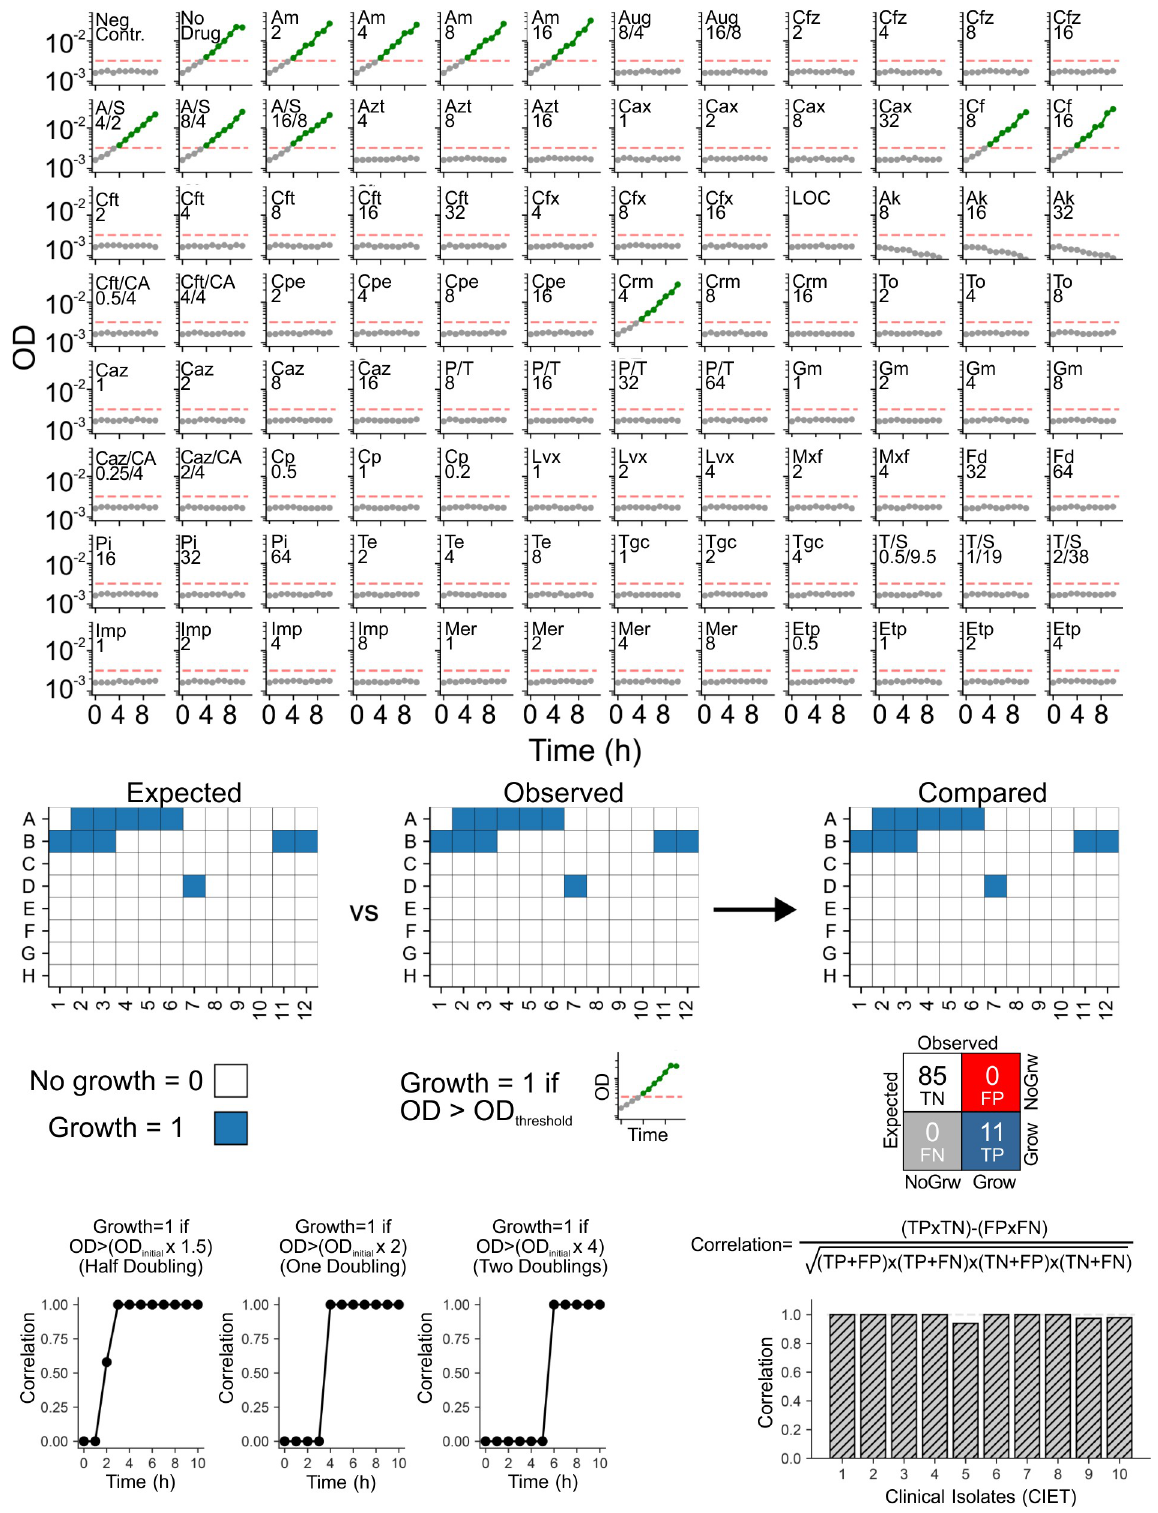
Fig 4. iFAST yields reliable results in shorter times in comparison to standard commercial clinical antibiotic susceptibility testing methods. (a) Utilizing the high sensitivity of the RUSD platform, iFAST can track growth of clinical isolates starting from the initial OD = 2 × 10 − 3 in antibiotic susceptibility test panels (NM43, Beckman Coulter). Cell densities of a clinical E . coli isolate (CIET-001) growing